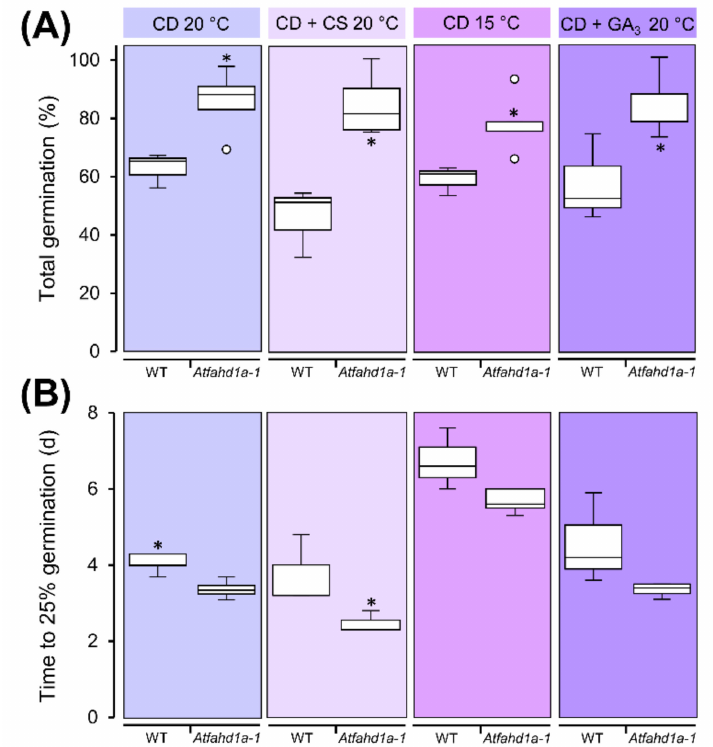
Figure 5. Longevity phenotypes of the second generation of wild type seeds [WT, ecotype Columbia- 0 (Col-0)] and Atfahd1a-1 (fumarylacetoacetate hydrolase domain-containing protein 1a) T-DNA insertional mutant seeds in the Col-0 background after 77 d of controlled deterioration (CD) at 40 ◦ C and 59.4 ± 1.1% RH. After CD, seeds were directly incubated at 20 ◦ C or exposed to dormancy breaking treatments prior to germination at 20 ◦ C. These included cold stratification (CS) and imbibition with 1 µ M of gibberellic acid (GA 3 ). To assess the presence of residual thermo-dormancy after CD, seeds were also incubated at 15 ◦ C. ( A ) Seed viability measured as total germination. ( B ) Germination rates expressed as time to 25% germination. Data for the various germination conditions are shown as box-plots ( n = 6 replicates of 100 seeds of both lines) and outliers as white circles. Asterisks denote significant differences between WT and Atfahd1a-1 seeds (Mann-Whitney U tests, p <